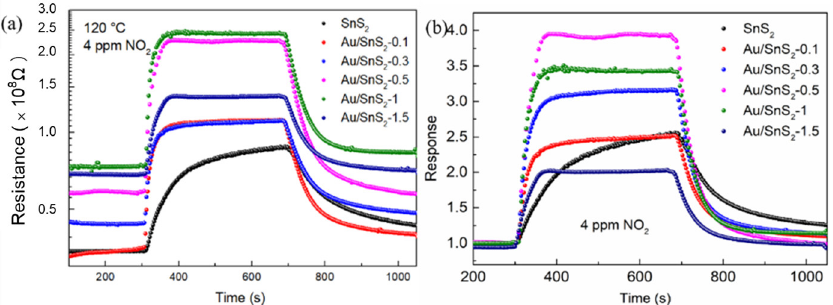
Figure 8. ( a ) The resistance and ( b ) the response curves of SnS 2 , Au/SnS 2 -0.1, Au/SnS 2 -0.3, Au/SnS 2 -0.5, 0.5, Au/SnS 2 -1, and Au/SnS 2 -1.5-based sensors to 4 ppm NO 2 at 120 °C. Au/SnS 2 -1, and Au/SnS 2 -1.5-based sensors to 4 ppm NO 2 at 120 ◦